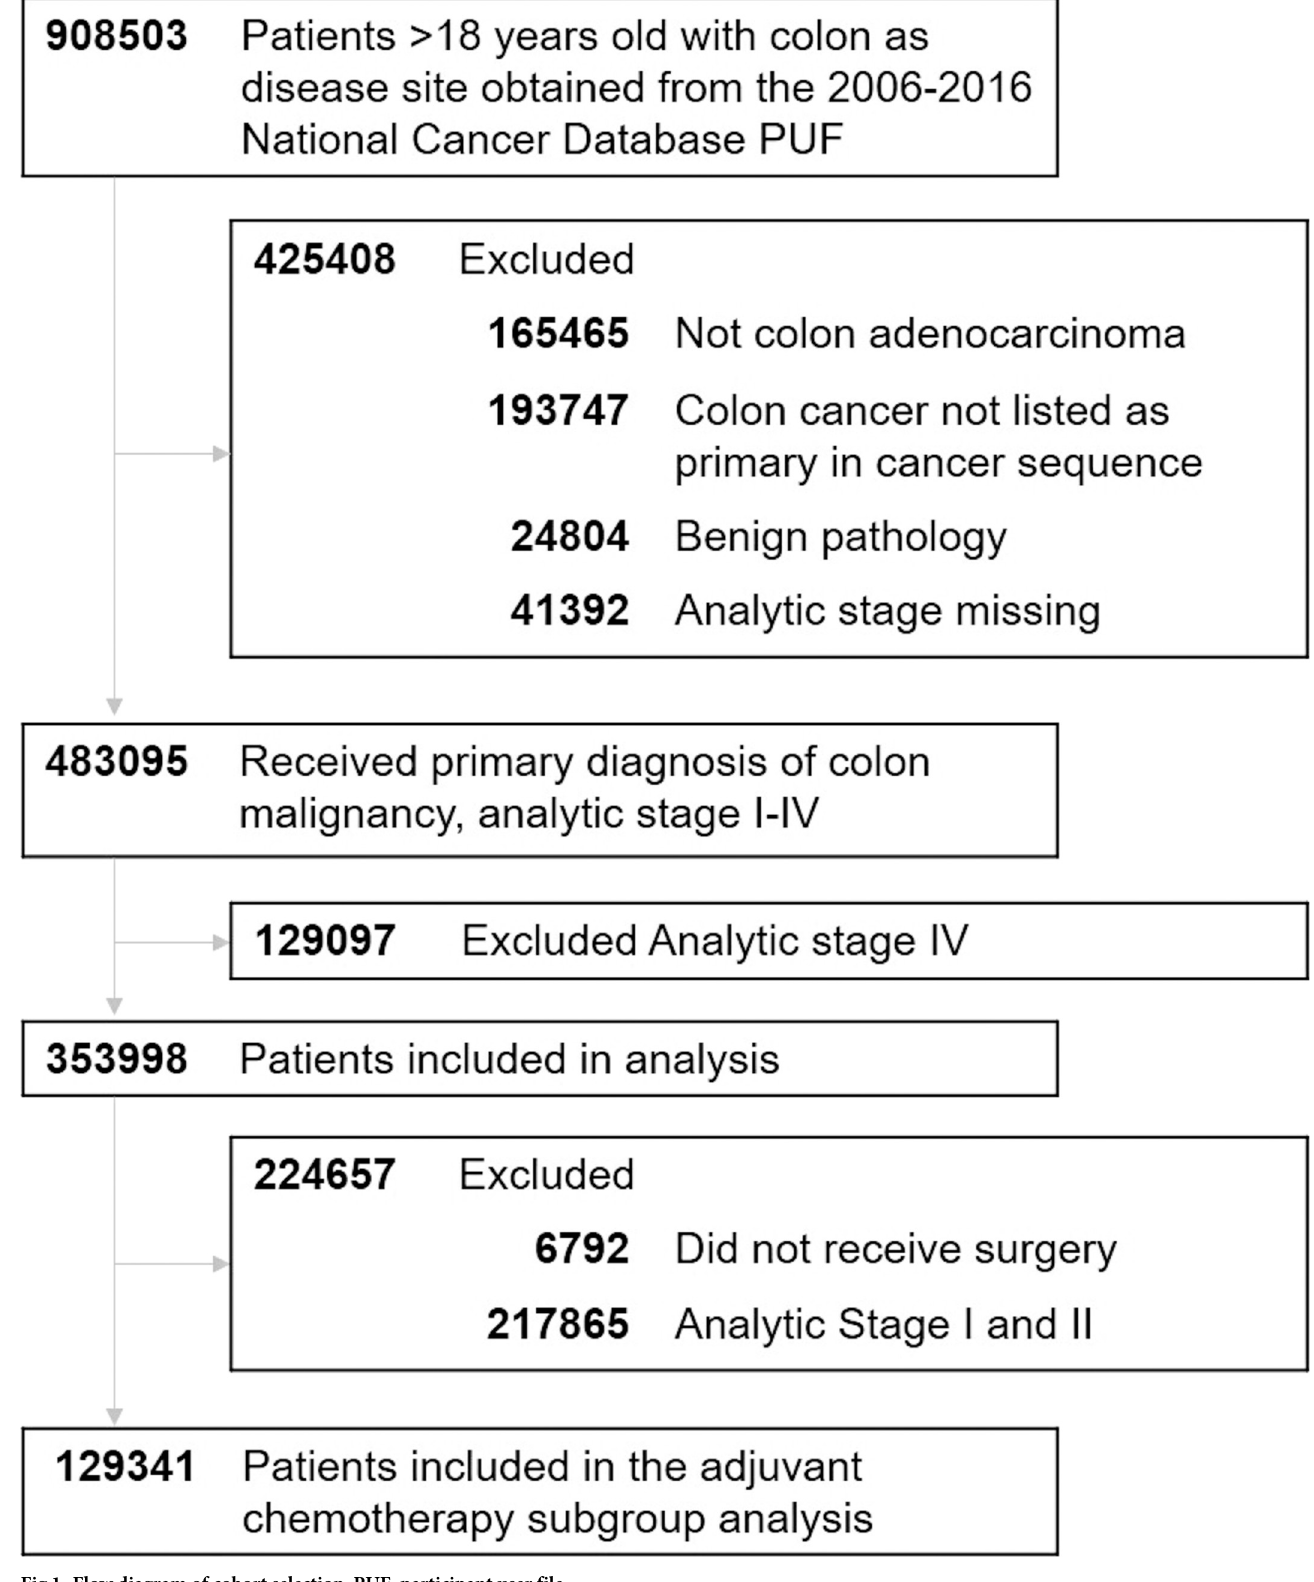
Fig 1. Flow diagram of cohort selection. PUF, participant user file.